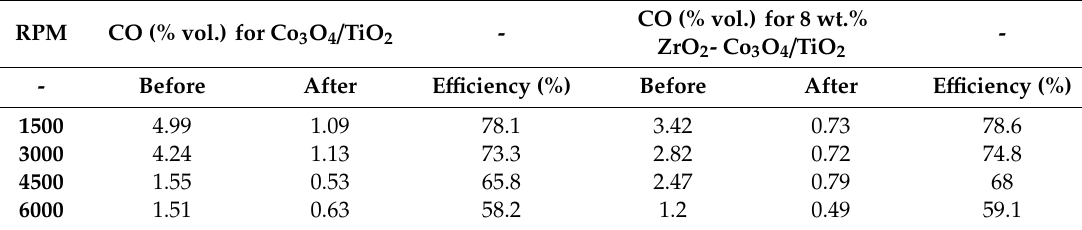
Table 2. Real time conversion results of CO with both catalysts.